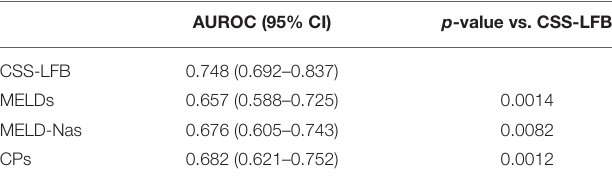
TABLE 6 | Comparison of the area under the ROC curve of predicting long-term (180 days) prognosis of patients with hepatitis B liver failure among Chinese scoring system, MELD score, MELD-Na scoring, and CTP